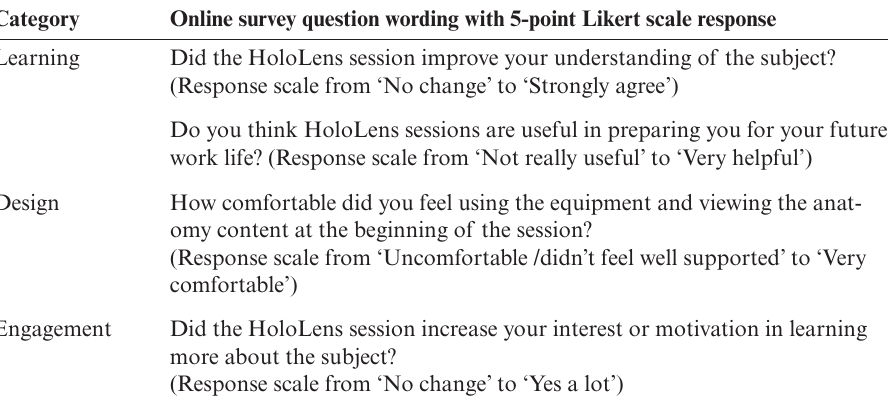
Table 1. Online survey questions aligned with broad LOES-S categories.